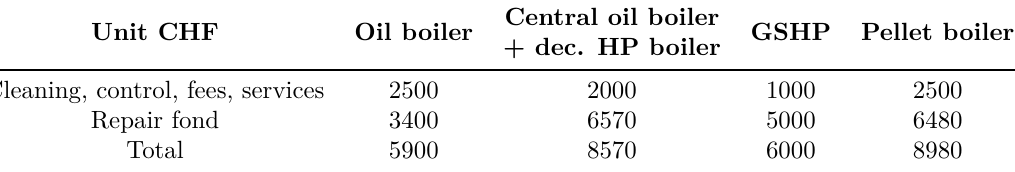
Table 3. Maintenance costs (in CHF).